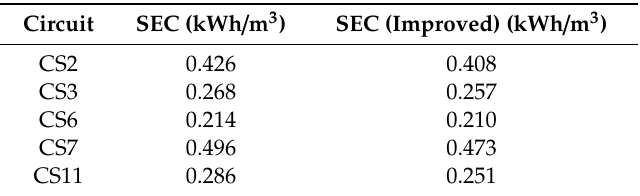
Table 9. Specific energy consumption for the non-improved and improved scenarios for each circuit. Circuit